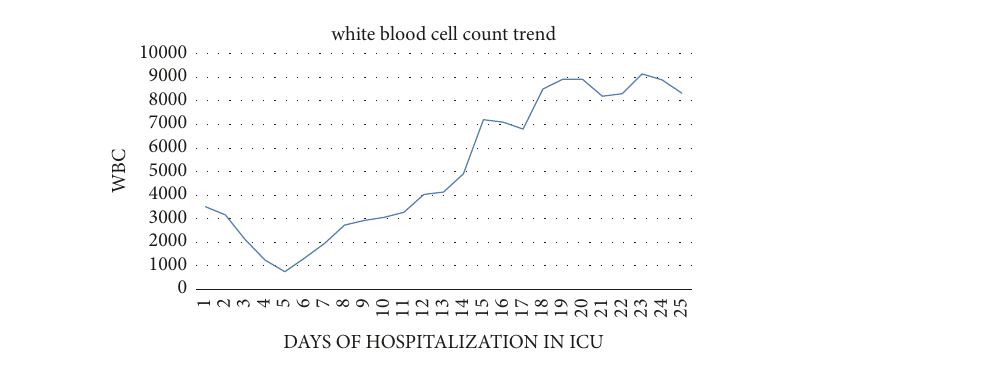
Figure 3: WBC count trend (the therapy with ceftolozane/tazobactam started on day 19’).